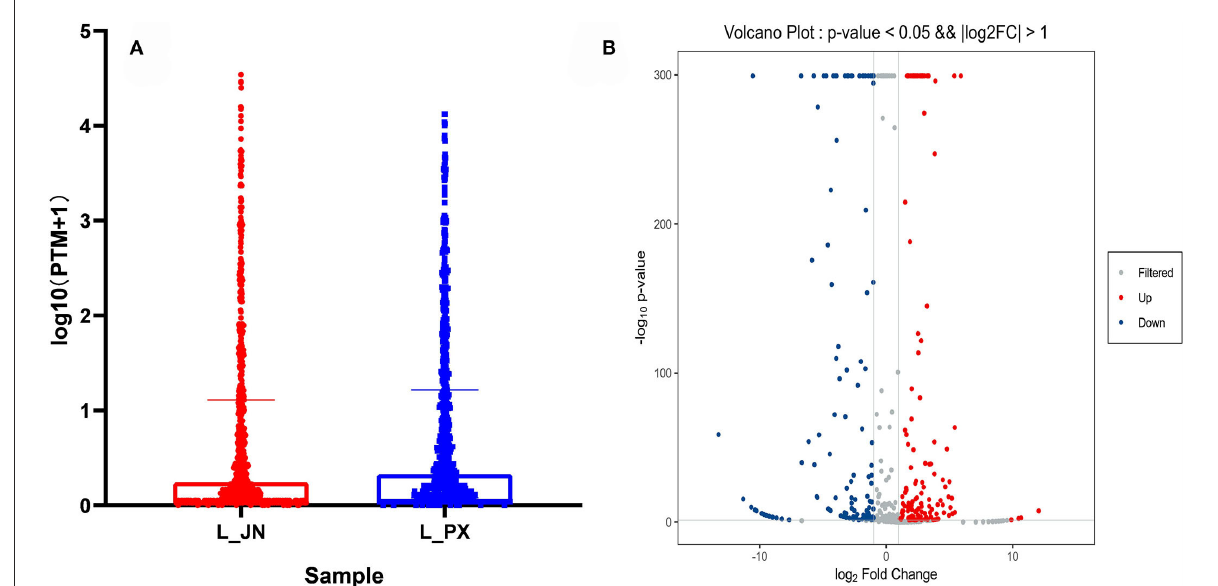
FIGURE3 Differential expression of miRNAs. (A) Horizontal box diagram of miRNA expression. (B) Volcano map of differentially expressed miRNAs. The scatter in the figure represents the miRNAs, the black dots indicate the miRNAs with no significant differences, the red dots indicating a significant up-regulation of the miRNA, and the blue dots represent a significant down-regulation of the